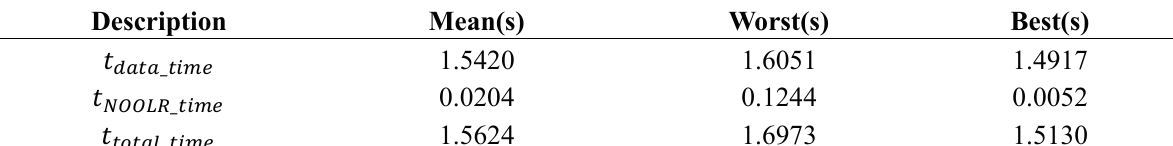
Table 2. Running time for NOOLR in the experiment.